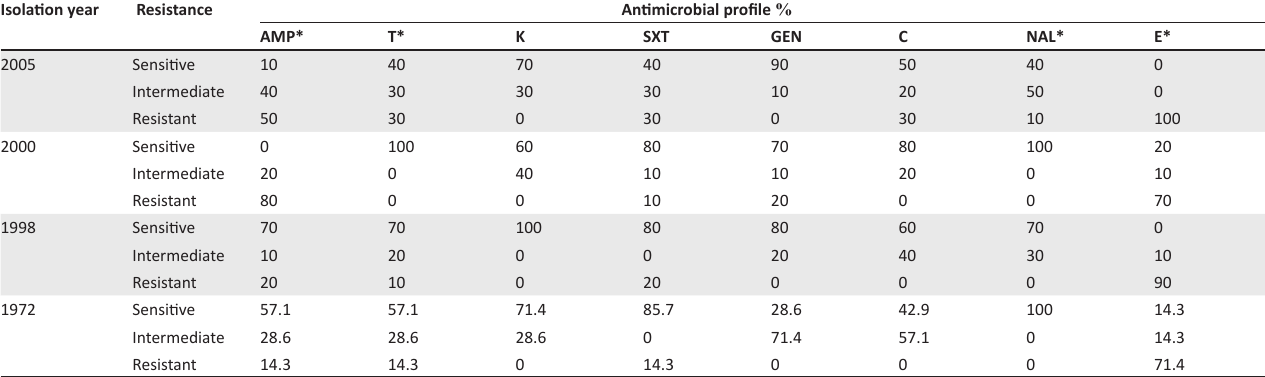
TABLE 1: General percentages of antimicrobial resistance amongst Salmonella enteritidis isolates obtained from the Central Veterinary Laboratory (1972–2005). Isolation year Resistance Antimicrobial profile %